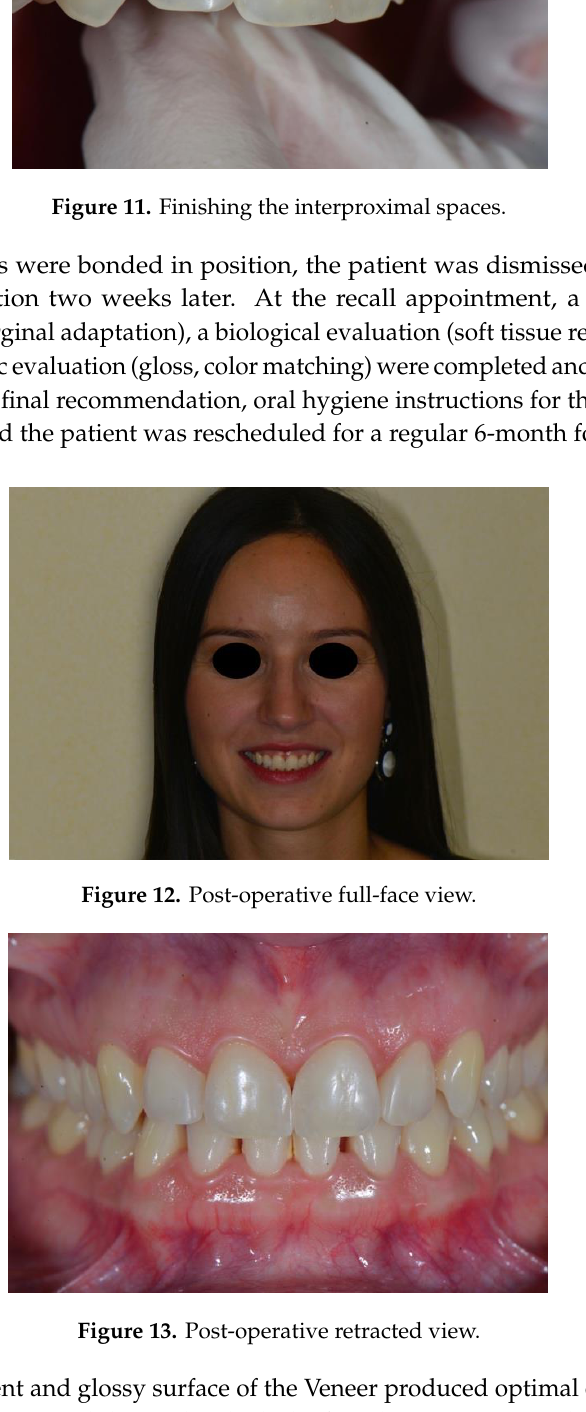
Figure 11. Finishing the interproximal spaces.